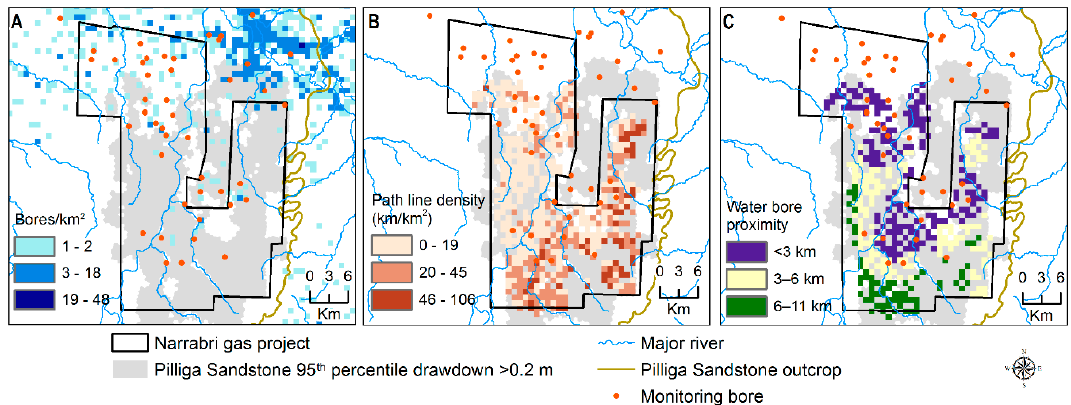
Figure 7. Water bore density ( A ), path line density from multiple forward tracking analysis ( B ), and water bore proximity based on Euclidean distances to planned CSG well locations ( C ).